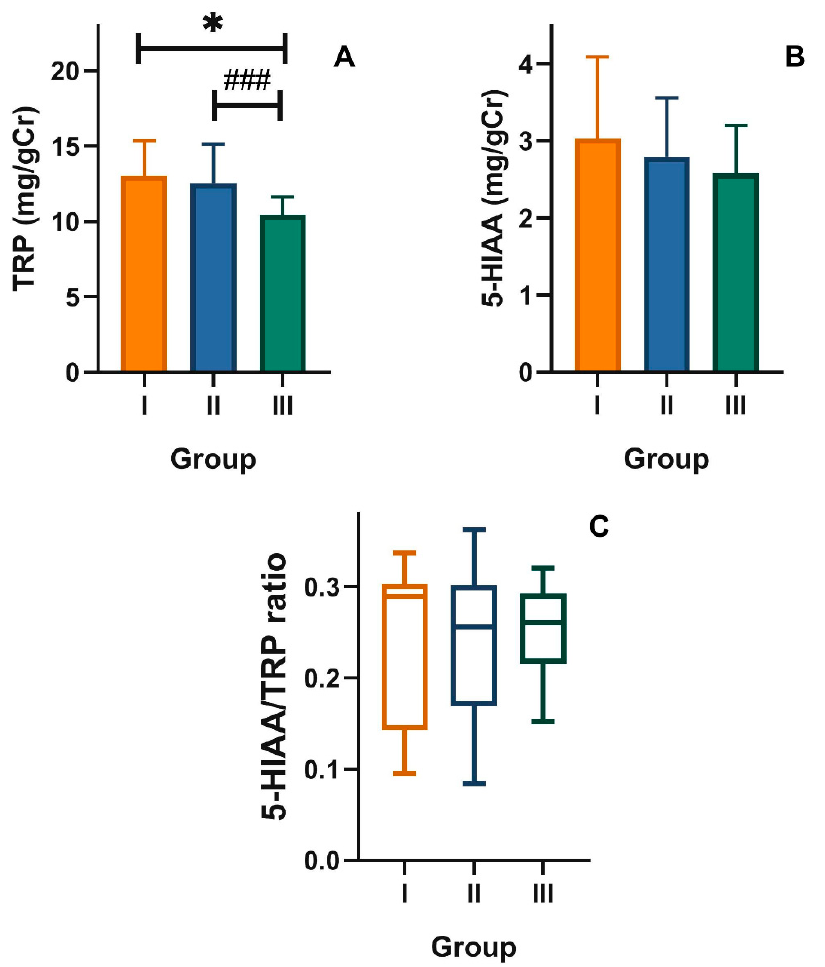
Figure 1. Urinary levels of ( A ) tryptophan (TRP) and ( B ) 5-hydroxyaminoacetic acid (5-HIAA) expressed in milligram per gram of creatinine (mg/gCr), and ( C ) 5-HIAA/TRP ratio in healthy young adult individuals (group I) and in the elderly without (group II) and with mood disorders (group III); mean ± SD ( A , B ) or median with boxes represent I and III quartiles, and error bars represent 1.5 times the interquartile distance. Differences between groups were analyzed by ANOVA ( A , B ) with Dunnett’s multiple comparison method (group III vs. I) or contrast (III vs. II); the differences between groups in C were assessed by Kruskal–Wallis test; n = 30 in each group; * p < 0.05; ### p < 0.001.